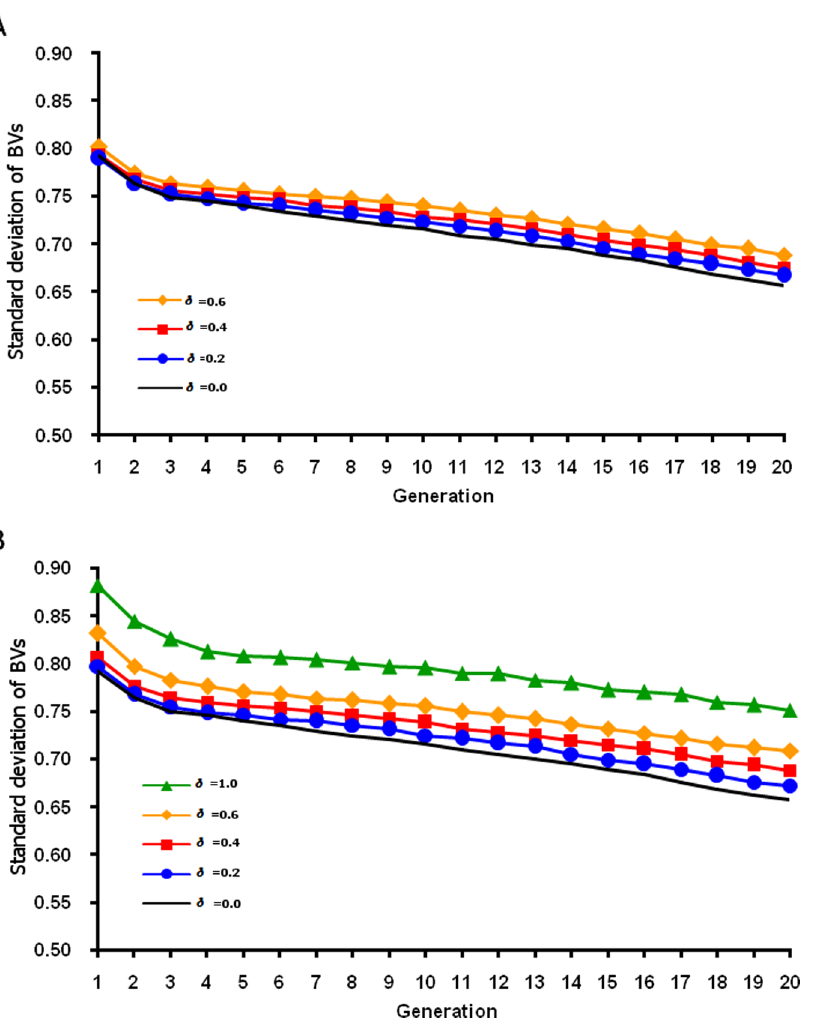
Figure 5. Standard deviation of true breeding value by generation based on a normal QTL distribution. True breeding values (BVs) for a simulated population were based on unweighted ( d =0) or weighted (various d ) genomic selection and calculated using on true marker effects. Linear (A) and nonlinear (B) formulas were used to weight allele frequency.